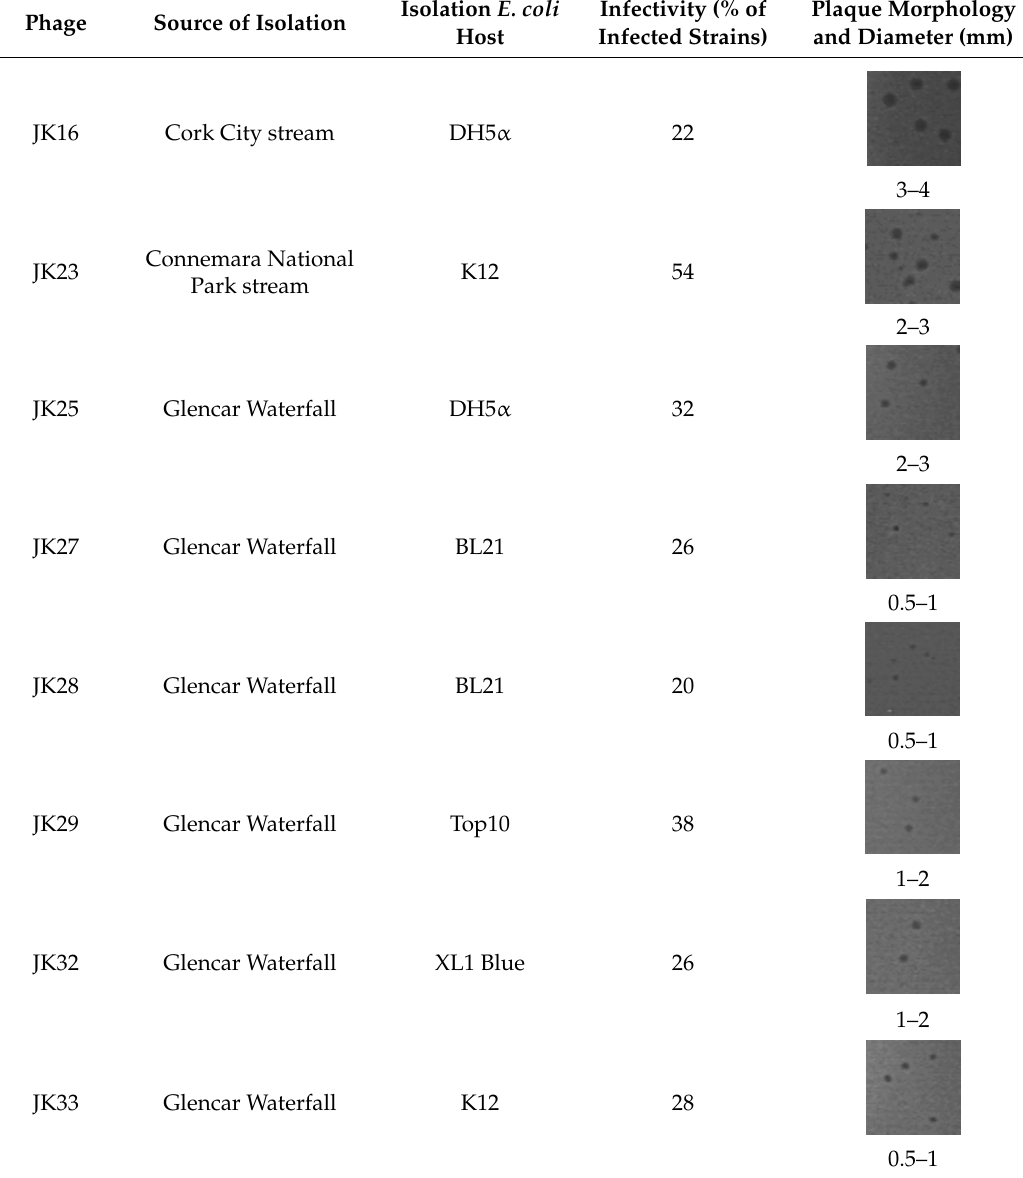
Table 1. Host range and plaque morphology of the 19 phages examined in this paper. Phages were isolated from various environments: natural springs, industrial waste water and chicken meat. The infectivity of the phages was calculated based on the host range (Figure 1). Phages exhibited various plaque morphologies, varying from very small (less than 0.5 mm diameter) to large (up to 4 mm diameter). Plaques were formed on agar plates with E. coli host that was used to isolate the phages.